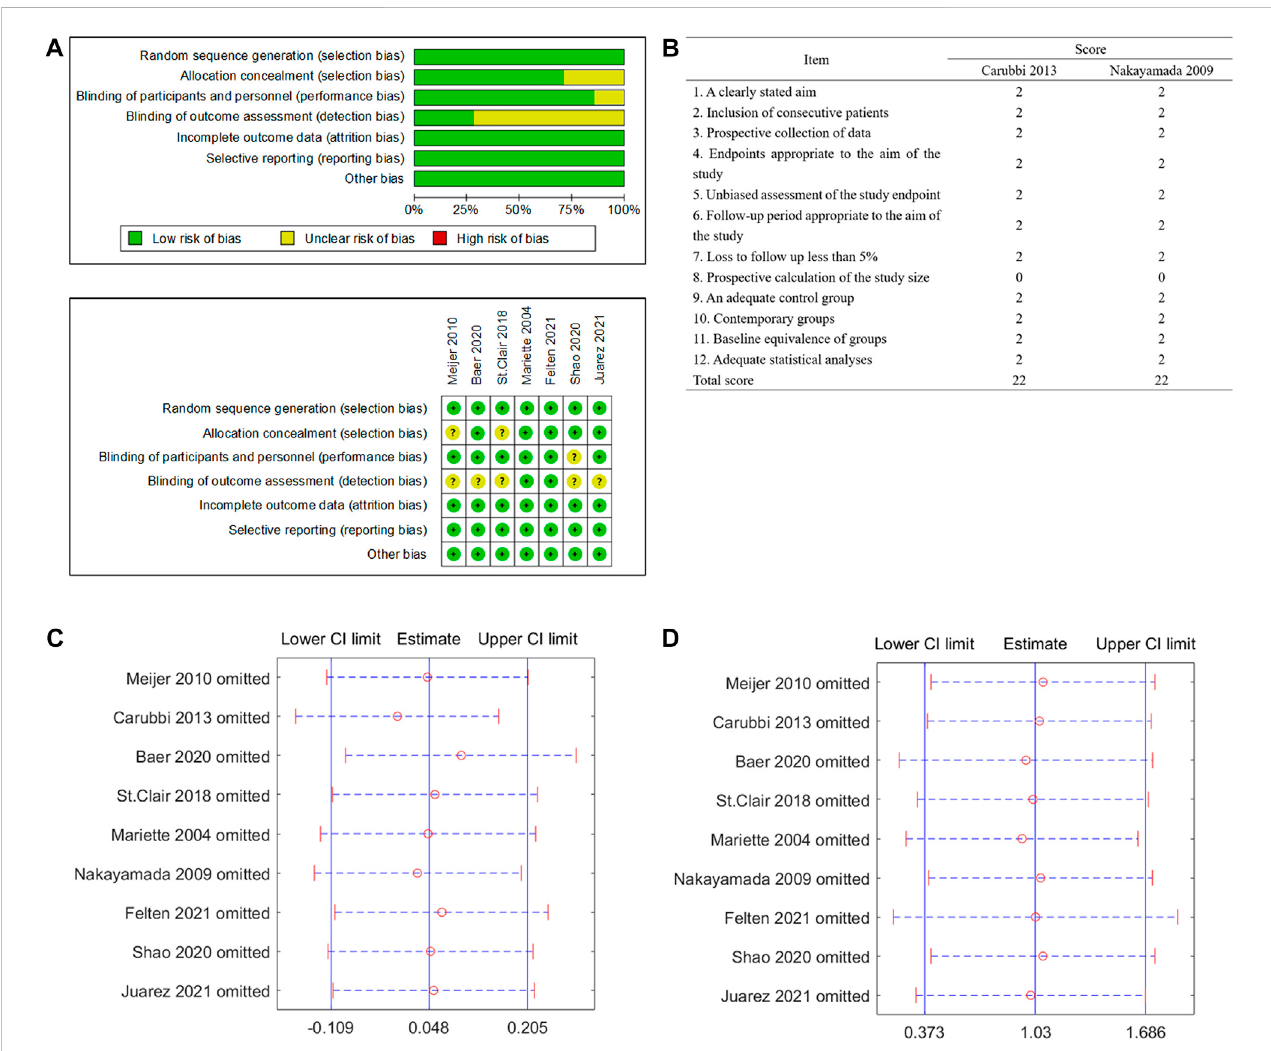
FIGURE 2 Quality assessment and sensitivity analysis of included studies. (A) Randomized controlled trials (RCTs) assessed by the Cochrane risk of bias tool. (B) Non-RCT trials assessed by the Methodological Index for Non-Randomized Studies (MINORS) scoring system. (C) Sensitivity analysis of the change of unstimulated whole saliva (UWS). (D) Sensitivity analysis of the occurrence of serious adverse events